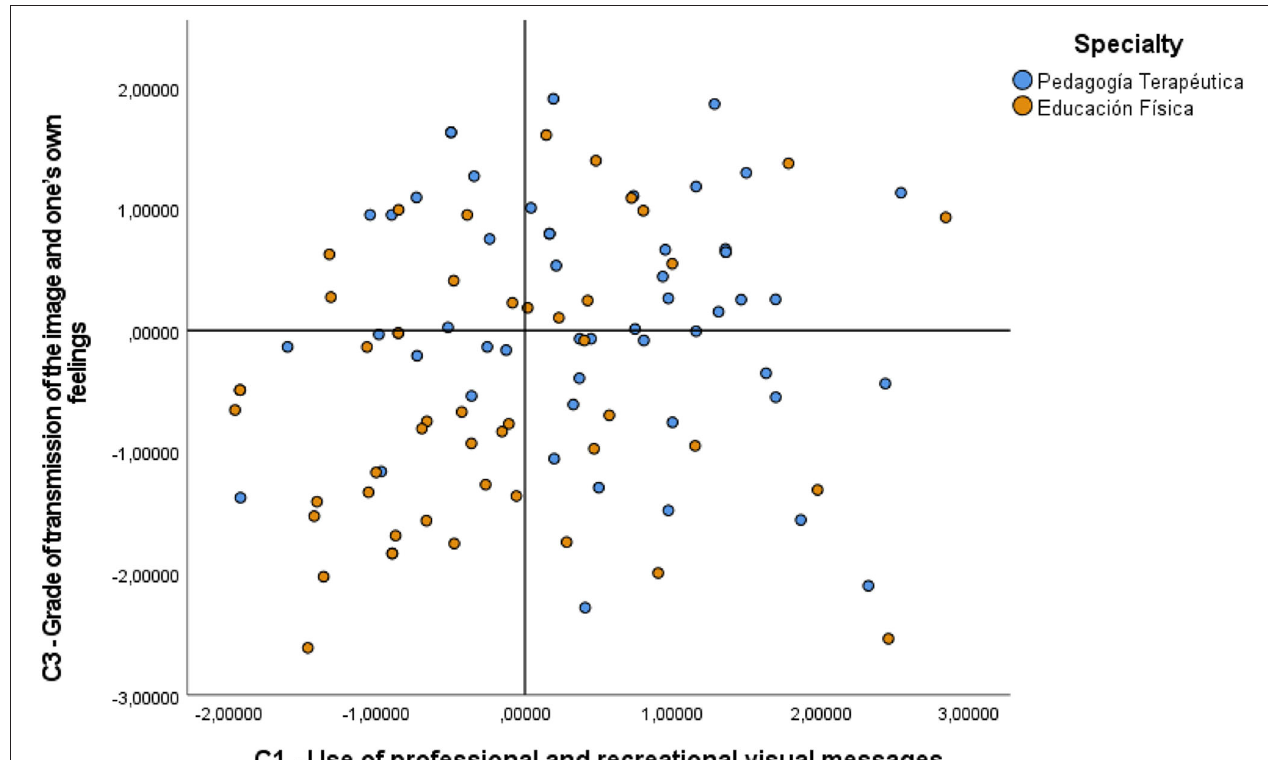
FIGURE 1 | Comparative C1 and C3 with specialties